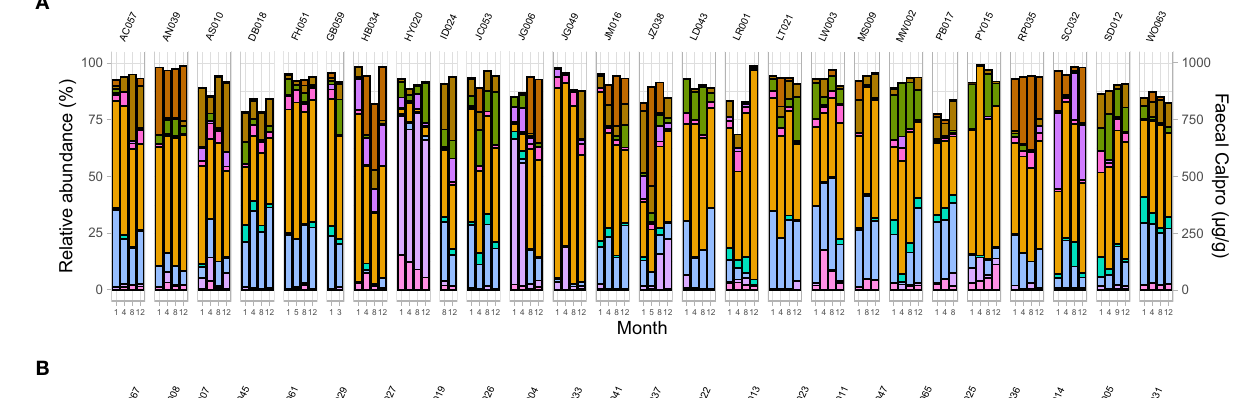
FIGURE 6 | Microbial community composition at family level in IBD patients across two treatment options including changes in FC concentration over time in (A) CD, and (B) UC. Only families with a relative abundance ≥ 2% in any sample are shown.